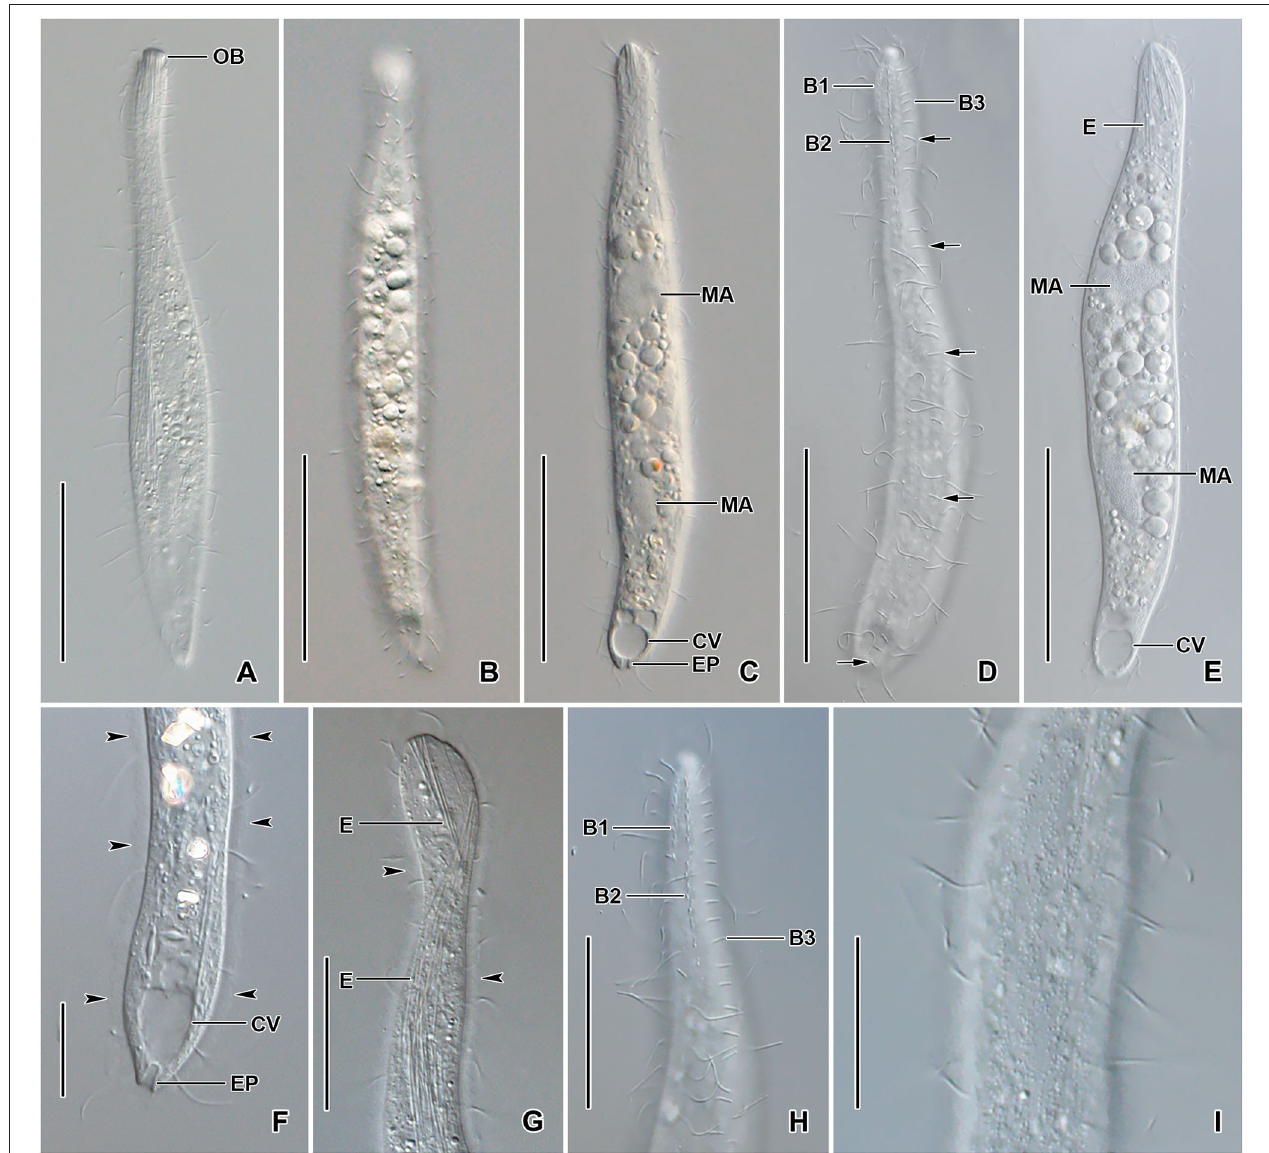
FIGURE 5 | Trachelophyllum parapiculatum sp. nov. from life. (A–E) Overviews showing the body shape, the two widely spaced macronuclear nodules, the terminal contractile vacuole, the excretory pore, and the long rod-shaped extrusomes. Arrows denote the bipolar dorsal brush row 3. (F,G) Posterior (F) and anterior (G) body portion showing the contractile vacuole, the single excretory pore, and the extrusomes extending into the oral bulge. Arrowheads mark the mucilaginous layer. (H) Dorsal view of the anterior body portion showing the two dikinetidal and one monokinetidal brush rows. (I) Surface view showing the cortical granulation. B1–3, dorsal brush rows; CV, contractile vacuoles; E, extrusomes; EP, excretory pore; MA, macronuclear nodules; OB, oral bulge. Scale bars = 50 µ m (A–E) , 30 µ m (H) , 20 µ m (G,I) , and 15 µ m (F)